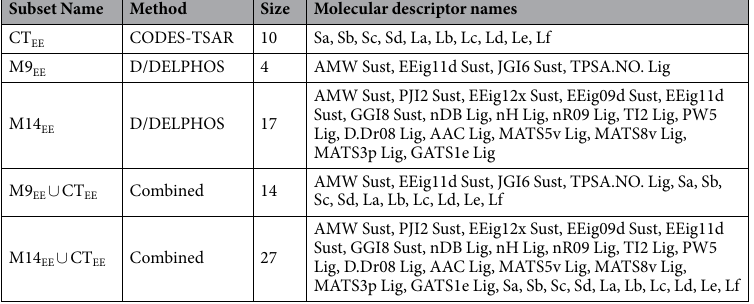
Table 4. Molecular descriptor subsets used for inferring the QSAR models for enantiomeric